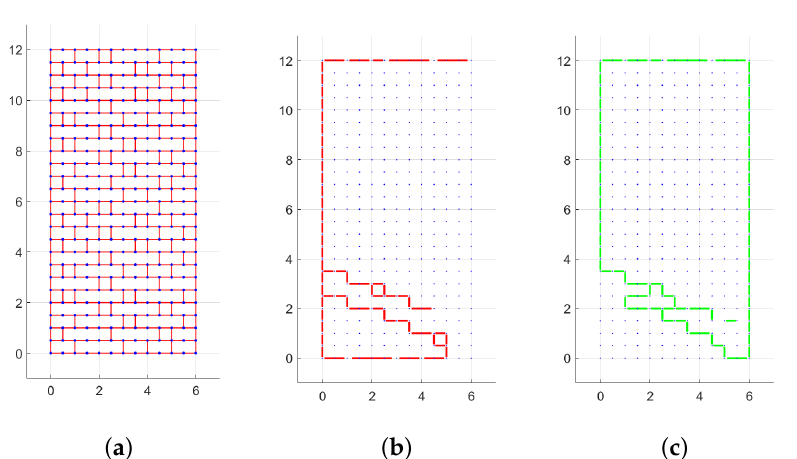
Figure 10. Quasi-periodic masonry with H / W = 2: ( a ) texture, ( b ) layout of displacements ( s ) for right oriented force, ( c ) layout of rotations ( w ) for right oriented force. (Dimensions expressed in